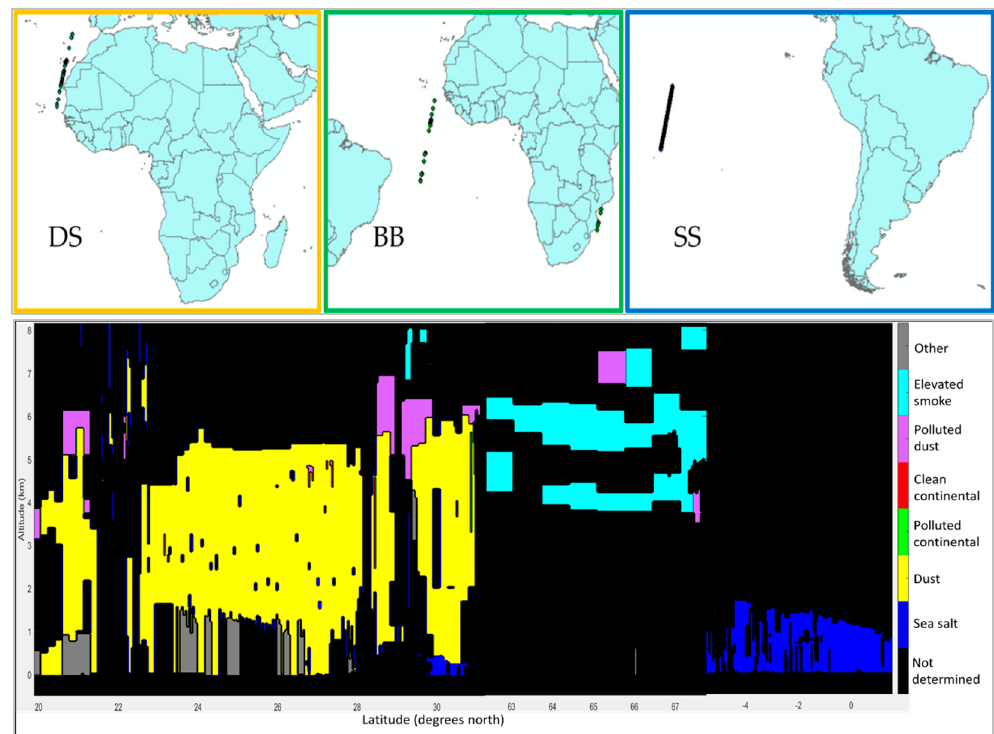
Figure 5. Tracks of CALIPSO subtypes for dust (DS), biomass burning (BB), and sea salt (SS) ( upper ), and vertical aerosol subtypes for the corresponding tracks (lower).